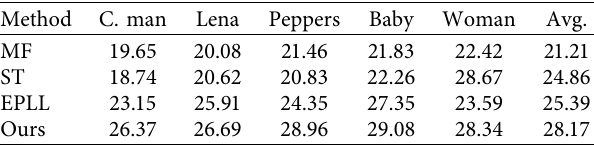
Table 2: Experimental results with more Gaussian noise